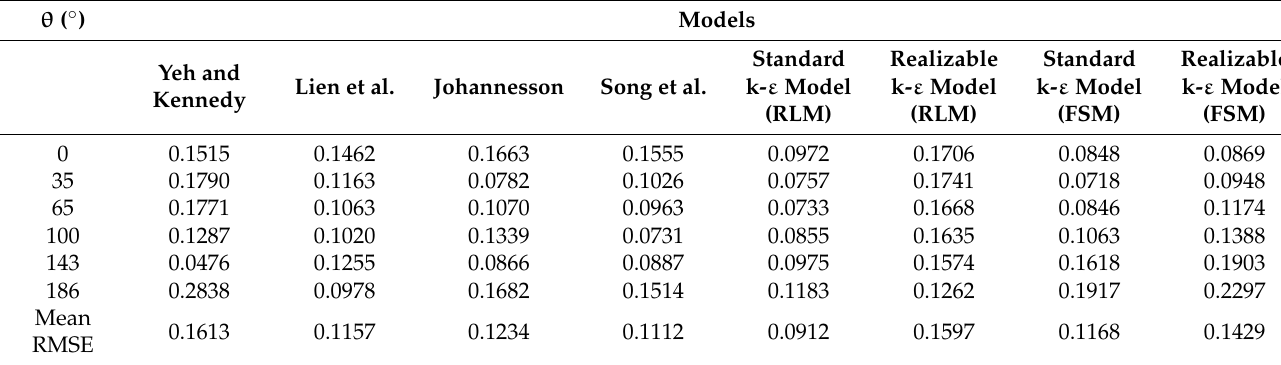
Table 2. RMSE estimation for resultant velocities in Figure